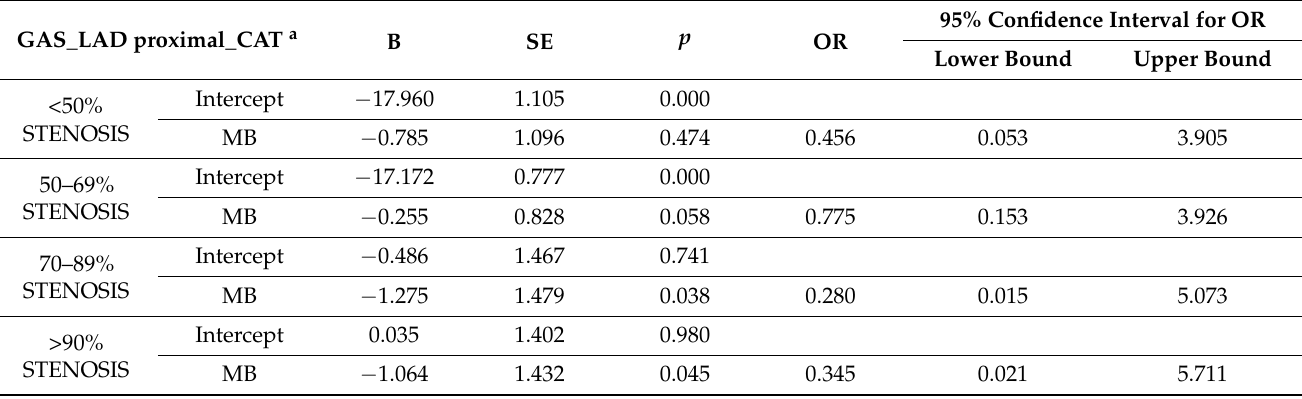
Table 5. Regression model for the probability of atherosclerotic stenosis on the proximal segment of left anterior descending artery in the presence of myocardial bridges.